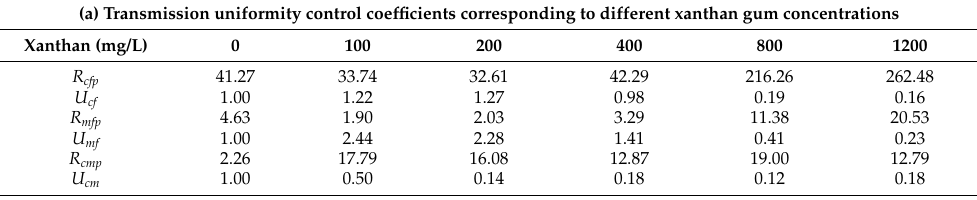
Table 5. Transmission uniformity control coefficients of each